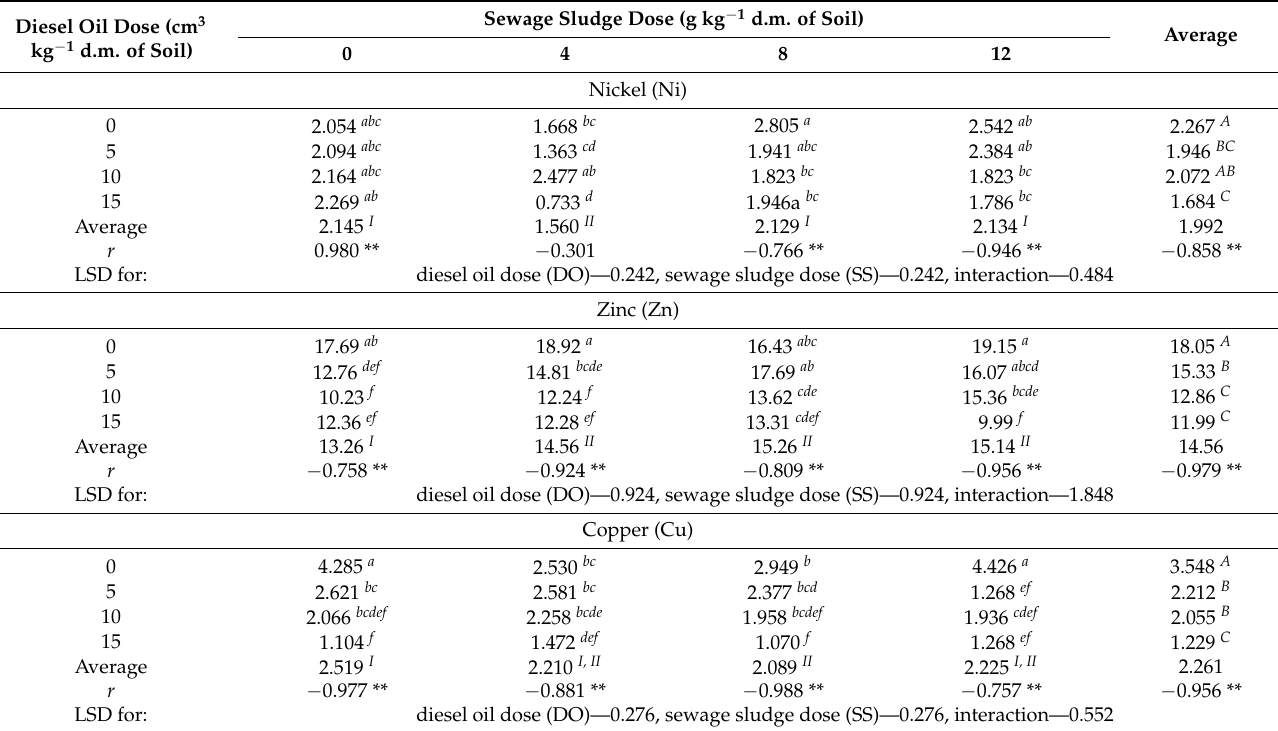
Table 3. Content of nickel (Ni), zinc (Zn) and copper (Cu) in aboveground parts of oat— Avena sativa L. (mg kg − 1 d.m.). Diesel Oil Dose (cm 3 kg − 1 d.m. of